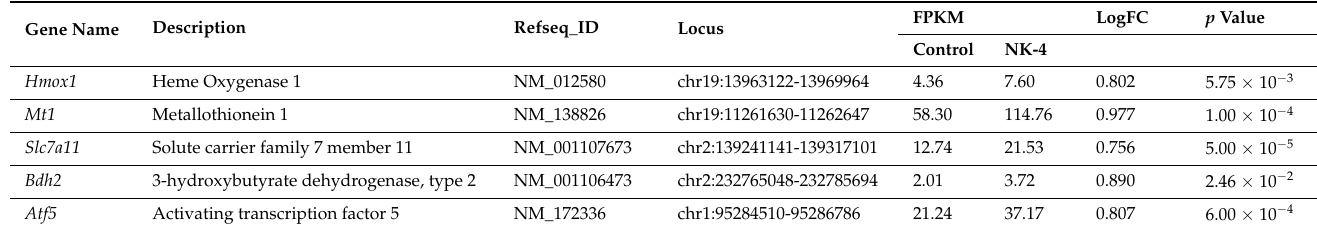
Table 1. 5 up-regulated genes in NK-4 treated retinas.